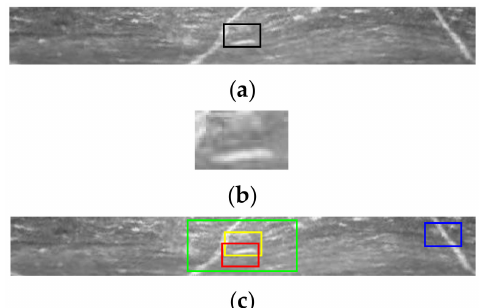
Figure 16. Three candidate images in fracture borehole image. ( a ) Resource image; ( b ) template and ( c ) examined image.